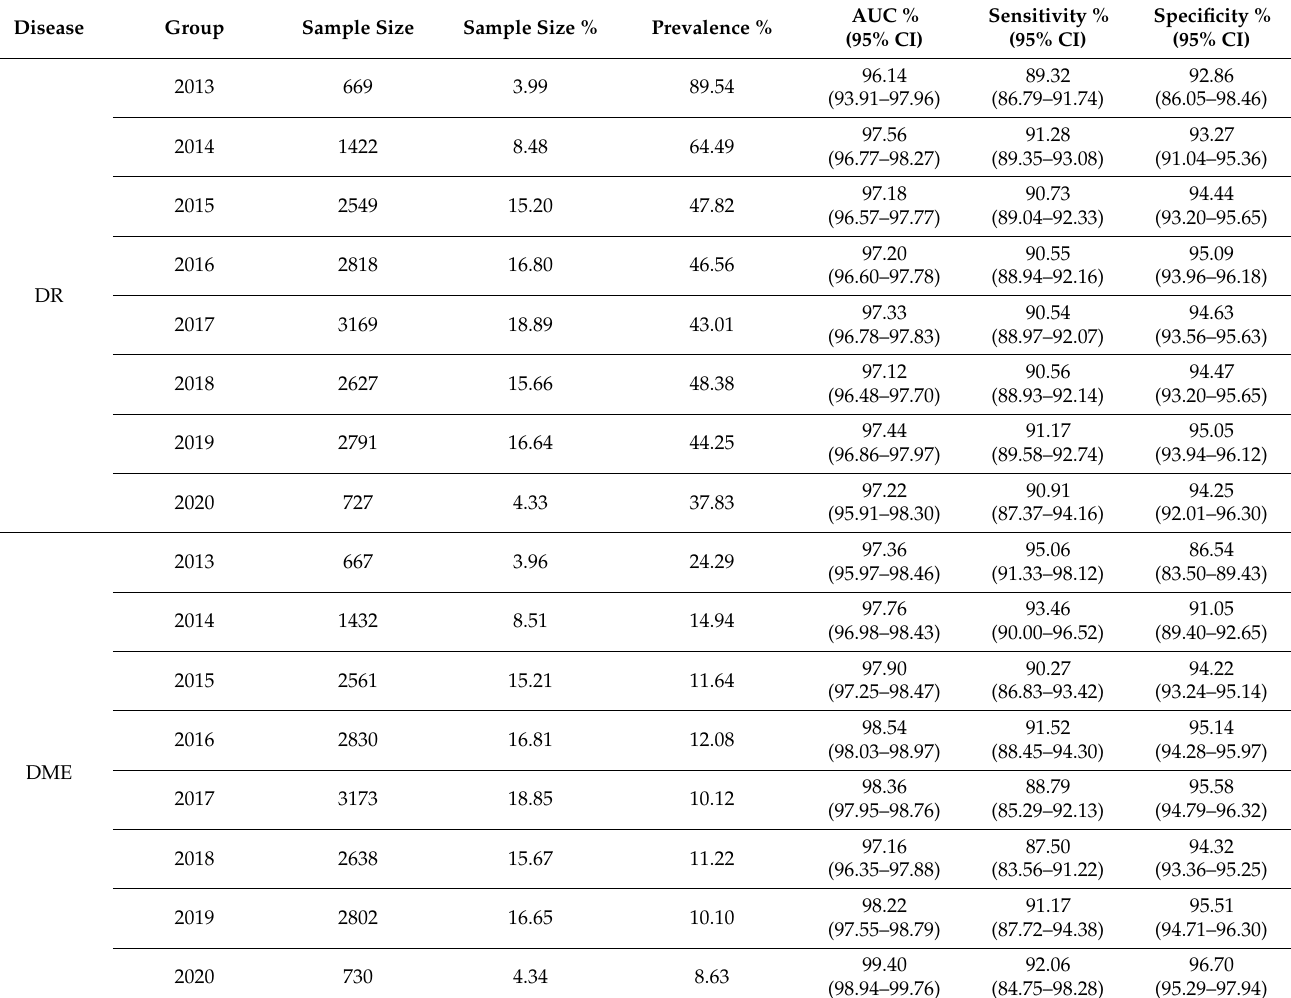
Table A5. Stratification results for the detection of referable retinopathy and diabetic macular edema on the patient level for year of exam.